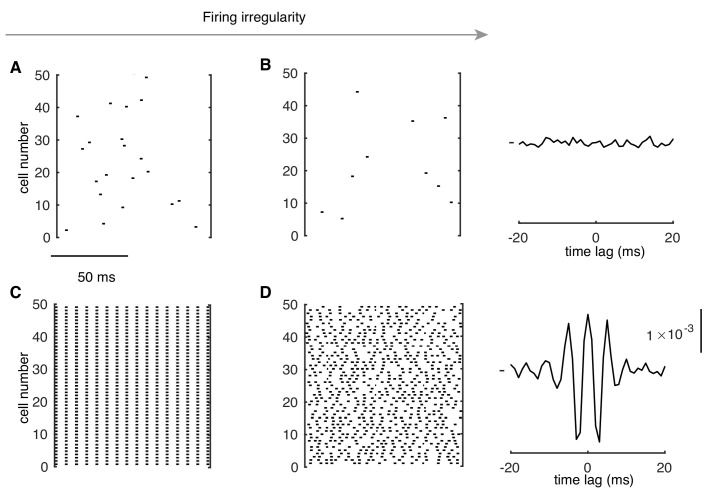
Formation of High-frequency Oscillations at High Rates.(A and B) Raster plots of random PC spikes when they fire regularly (CV ISI ~ 0.07) and irregularly (CV ISI ~ 0.4) at low rates (here,~2 Hz in the network, but 12 Hz in isolated cells). In the right plot of (B), average CCG is shown. (C) PCs show spike-to-spike synchrony when they fire regularly (CV ISI ~ 0.02) at high rates (154 Hz). (D) PC spikes show high-frequency oscillations when they fire irregularly (CV ISI ~ 0.44) at high rates (153 Hz). The right plot of (D) shows the average CCG with a significant central peak and side peaks.